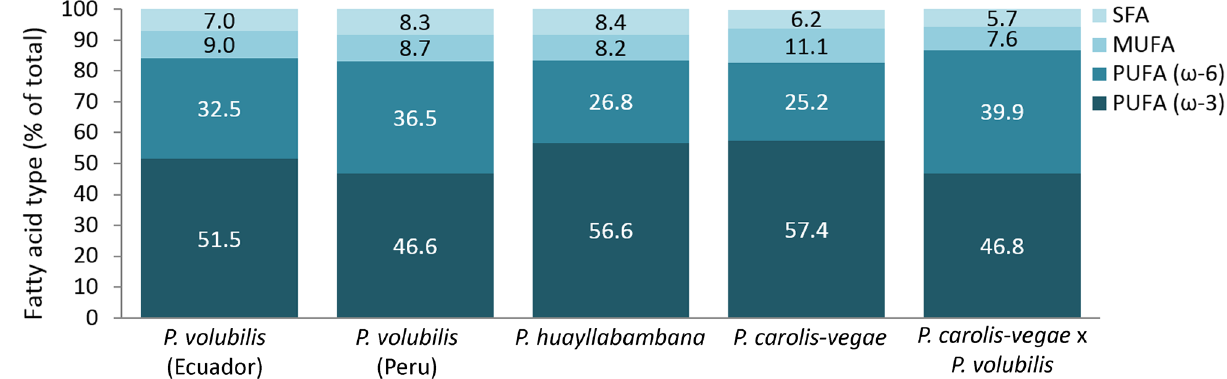
Figure 3. Relative distribution of saturated and unsaturated fatty acids in different species and cultivars of Plukenetia, n = 3 (except P. volubilis × P. carolis-vegae , n = 2). MUFA, monounsaturated fatty acids; PUFA, polyunsaturated fatty acids; SFA, saturated fatty